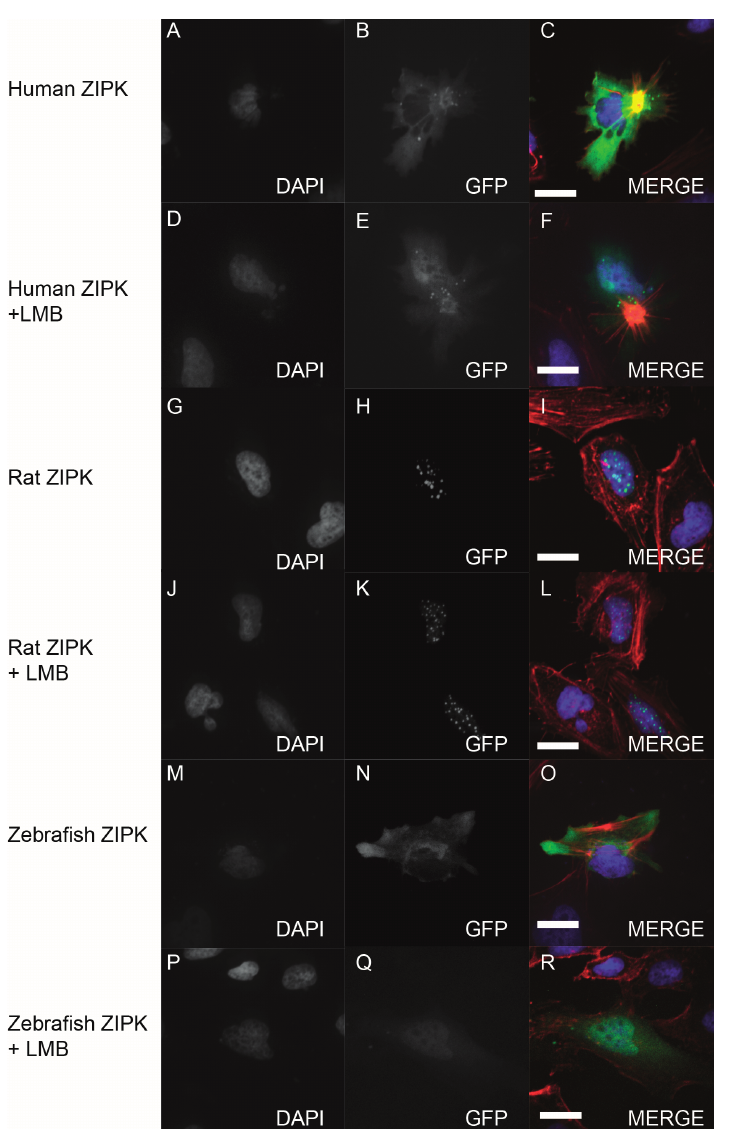
Figure 8. Nucleo-cytoplasmic shuttling of zebrafish ZIPK. HeLa cells were transfected with either human GFP-ZIPK ( A – F ); rat GFP-ZIPK ( G – L ); or zebrafish GFP-ZIPK ( M – R ). All cells were fixed and stained with DAPI and Alexa 568-phalloidin. The cells in ( A – C , G – I , M – O ) were treated with 0.1% DMSO; while the cells in ( D – F , J – L , P – R ) were treated with 50 nM leptomycin B for four hours. ( A , D , G , J , M , P ) are stained with DAPI; ( B , E , H , K , N , Q ) show subcellular localization of the GFP-fusion protein, while color images are a merge of DAPI (blue), GFP (green), and phalloidin (red). Each experiment was repeated three times with a minimum of 25 cells assayed per experiment. White bar indicates 20 μ